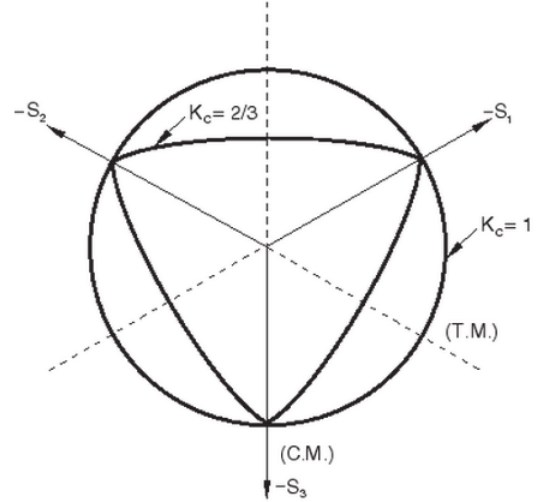
Figura 3 Seção transversal da superfície de plastificação no plano de Nadai, sendo -S1, -S2 e -S3 as